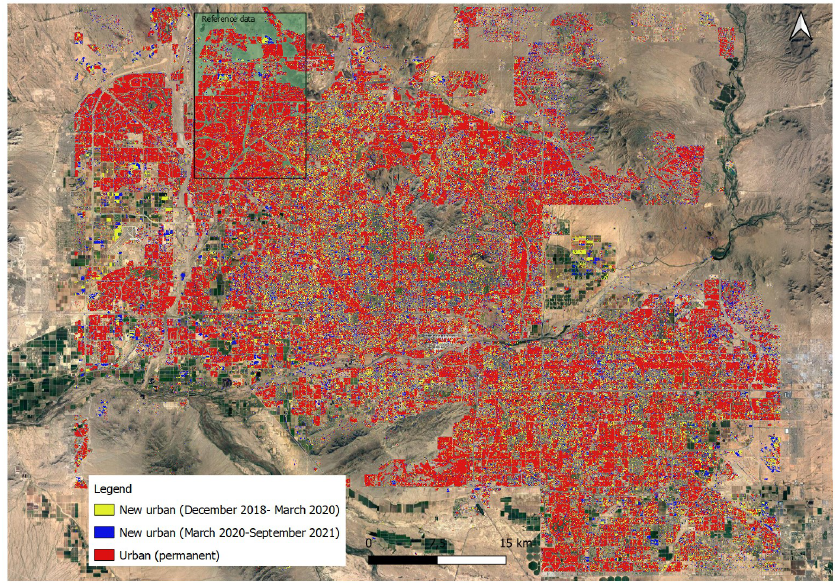
Figure 6. Sentinel-2 image mosaic with overlaid change detection results: Classes of Urban (perma-